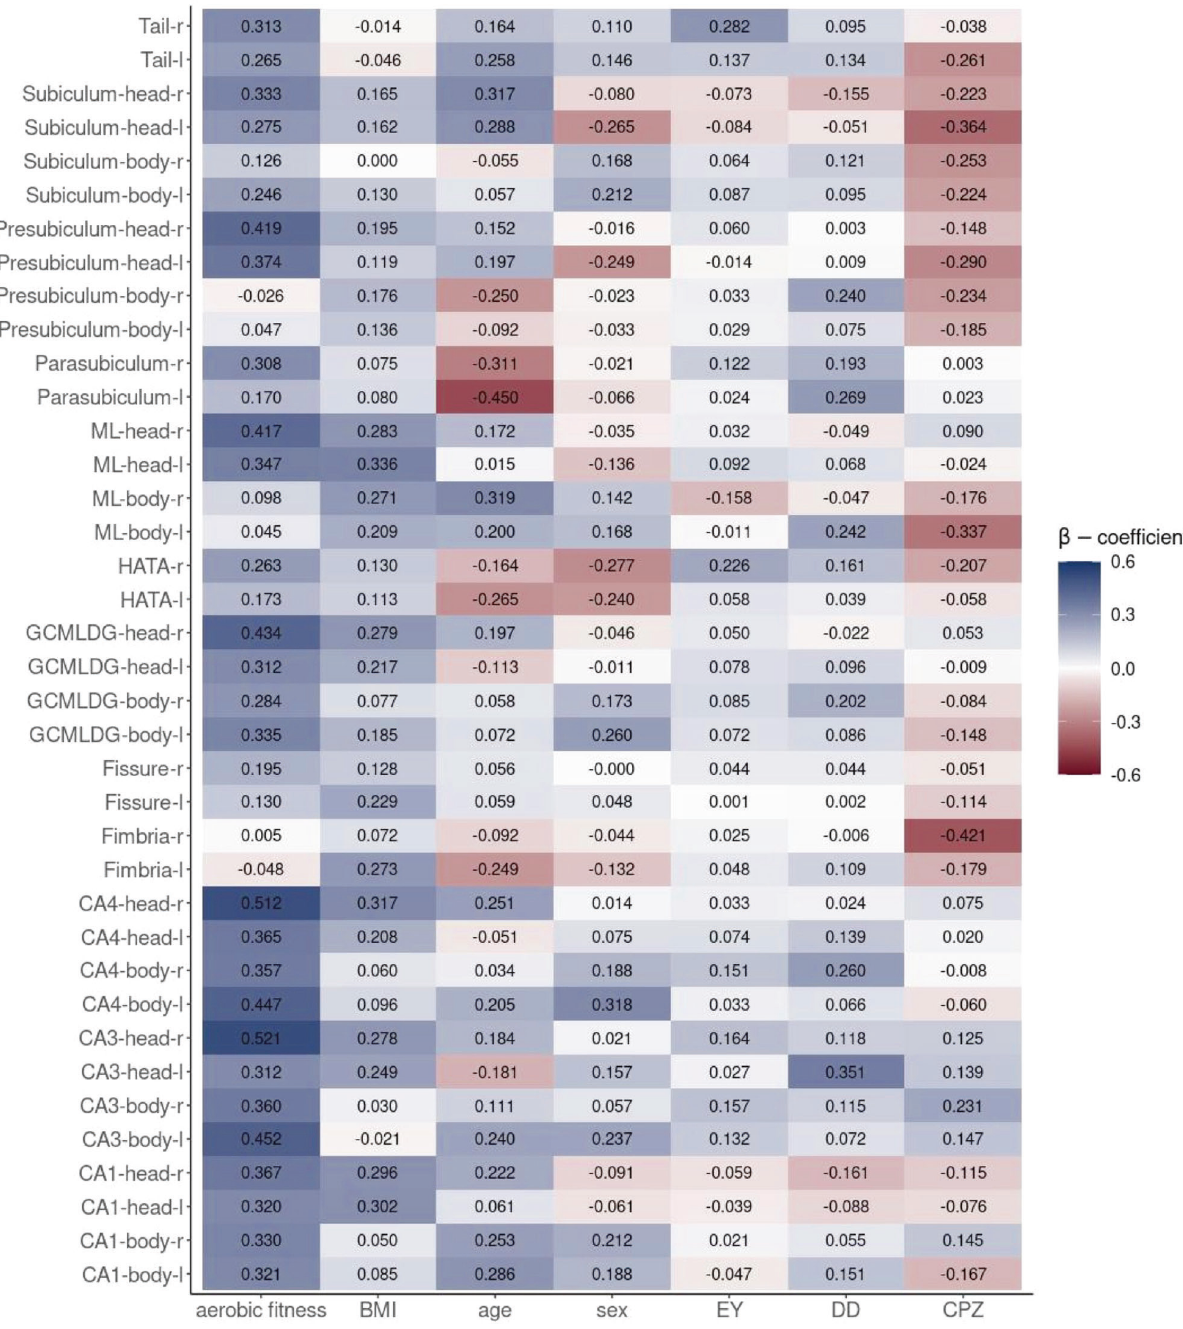
VLMT-STM and -LTM scores, resulting in 64 separate mediation analyses. No signi fi cant mediation effects were observed after controlling for the false discovery rate. Regarding the VLMT-STM score, signi fi cant positive mediation effects (evaluated with uncor- rected p values) were observed for the body of the left GCMLDG and the body of the left CA4 (Table 5). Regarding the VLMT-LTM score, a